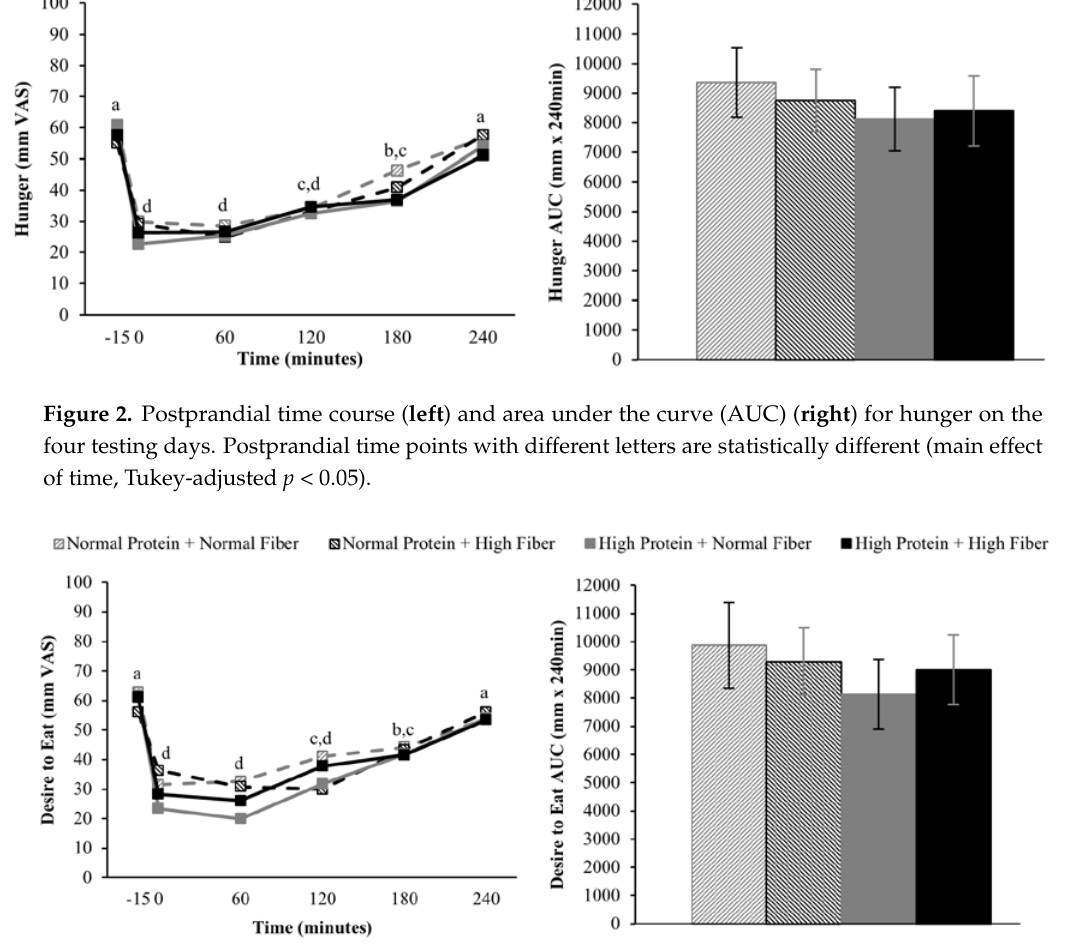
Figure 3. Postprandial time course ( left ) and AUC ( right ) for desire to eat on the four testing days. Postprandial time points with different letters are statistically different (main effect of time, Tukey-adjusted p < 0.05).